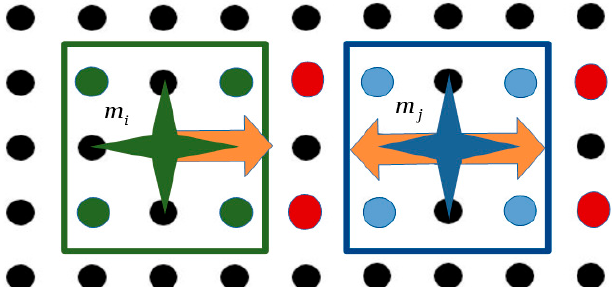
Figure 16. Both the m i & m j microparts should be displaced to the right side, but the activation for the